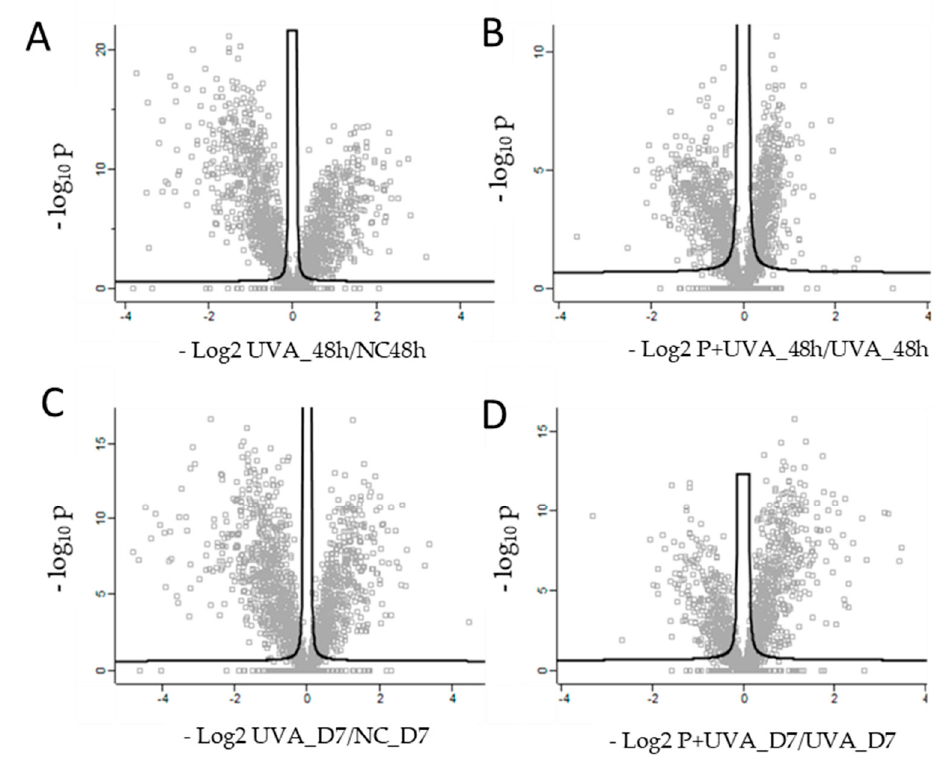
Figure 2. Scatter plots of log2 ratio on x-axis against -log10 p- value on y-axis of significantly quantified proteins resulted from two sided t -test. ( A ) Quantified proteins in human dermis spheroids after 48 h of UVA exposure (UVA_48hvsNC_48 h). ( B ) Quantified proteins in carnosine pre-treated dermis versus control at 48 h (P+UVA_48hvsUVA_48 h). ( C ) Quantified proteins in human dermis spheroids after D7 of UVA exposure versus control (UVA_D7vsNC_D7). ( D ) Quantified proteins in carnosine pre-treated dermis versus control at D7 (P+UVA_D7 vs. UVA_D7). Statistical parameters ( p < 0.05; q < 0.05, q = FDR adjusted p -value) were set to identify the differentially expressed proteins between samples. Biological and technical triplicates were analyzed. Table 1. Functional modules evoked by UVA exposure. Positive z-score indicates the activation pathway; negative z-score indicates the downregulation of the pathway (the analysis was performed by IPA (Qiagen) using the quantitative LFQ dataset).